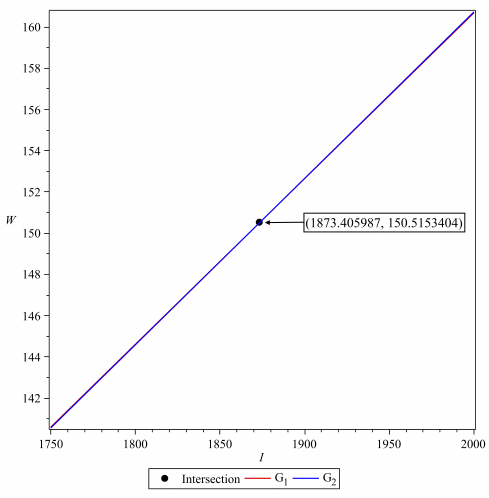
Figure 4. Illustration for the existence of malaria-endemic equilibrium